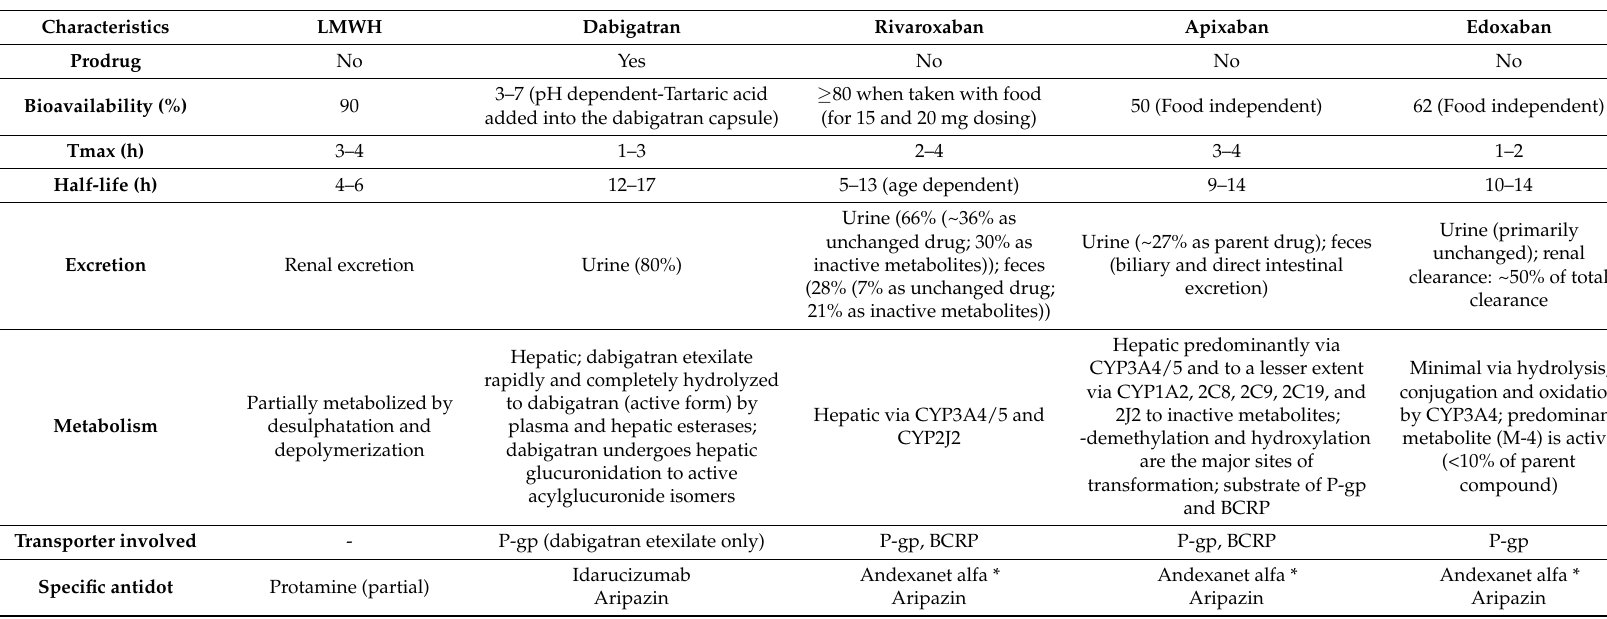
Table 3. Comparison of the Pharmacologic characteristics of Low-molecular-weight heparin with those of available direct oral anticoagulants. Characteristics LMWH Dabigatran Rivaroxaban Apixaban Edoxaban Prodrug No Yes No No No ≥ 80 when taken with food 3–7 (pH dependent-Tartaric acid Bioavailability (%) 90 added into the dabigatran capsule) (for 15 and 20 mg